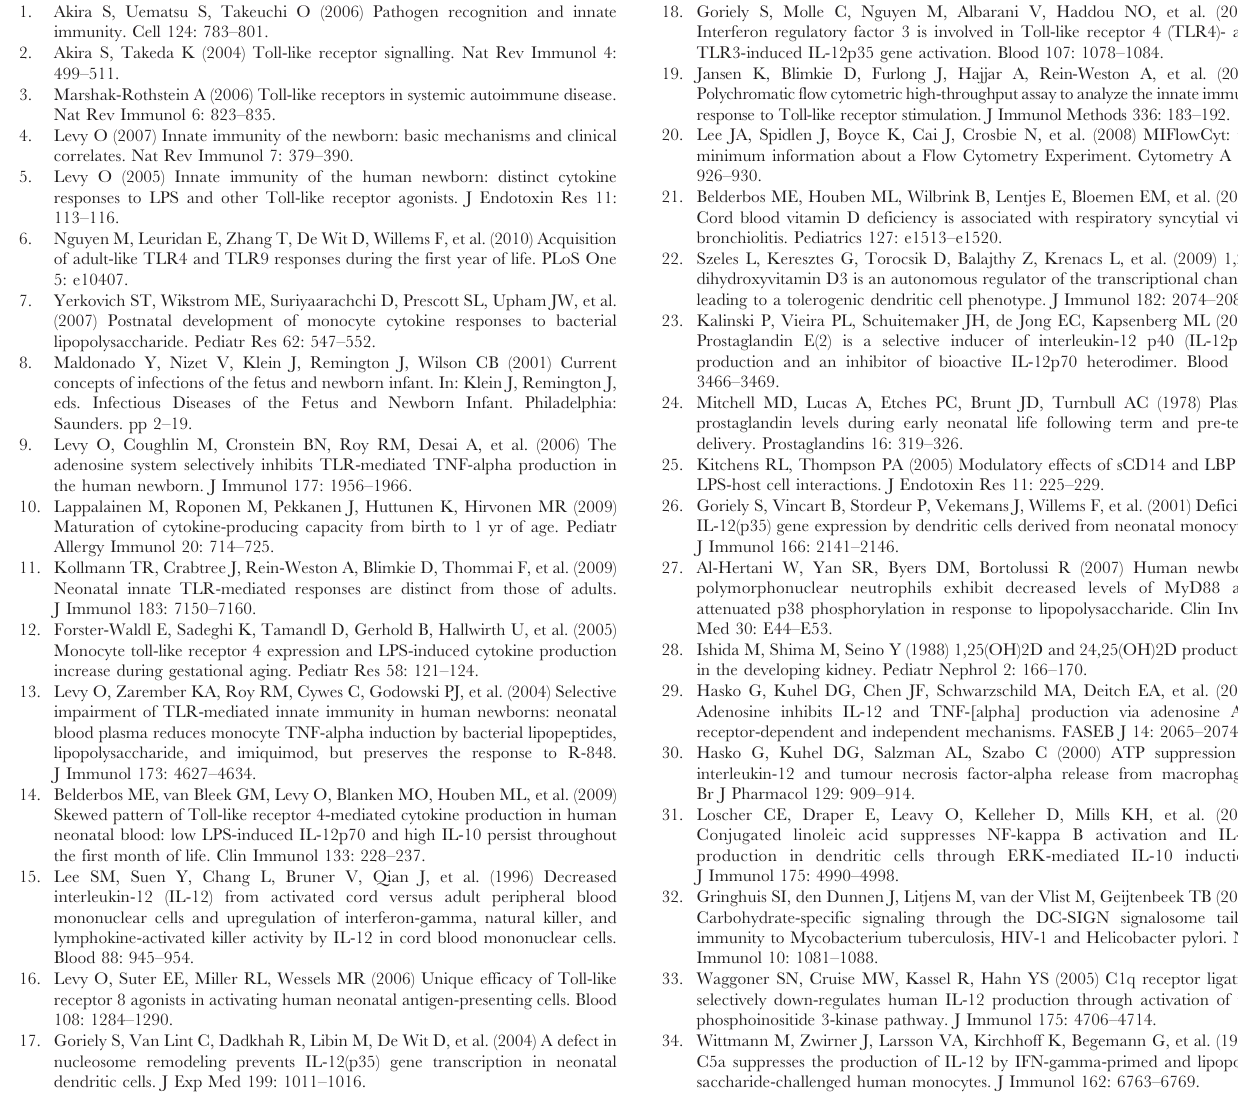
Figure S1 Flow cytometric detection of TLR4-mediated